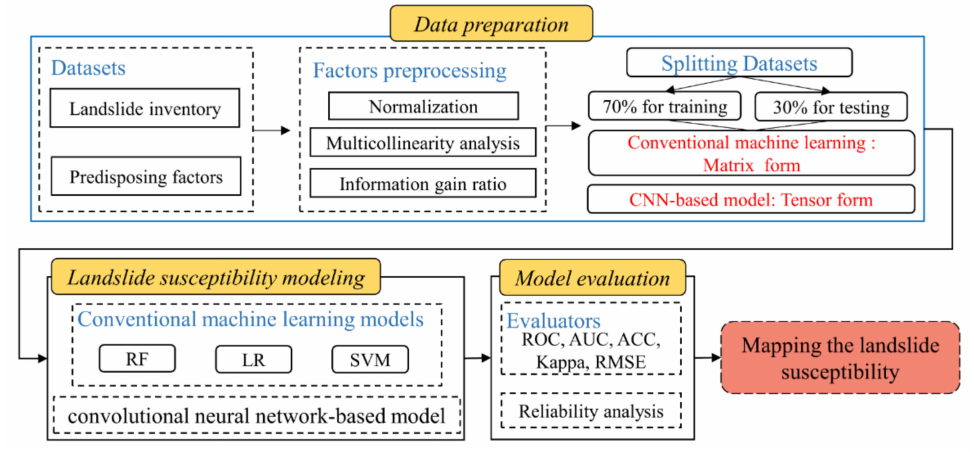
Figure 3. Flowchart of this